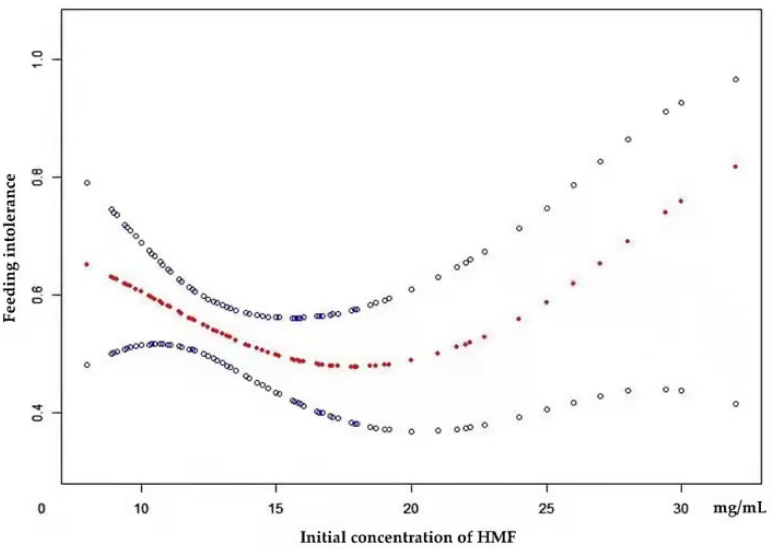
Figure 3. Estimated probability of experiencing feeding intolerance (FI) by initial concentration of human milk fortifier (HMF), based on a generalized additive model controlling for birth weight (BW), rate of milk supplementation, and HM volume when HMF supplement. The red curve in the middle is the spline smoothing, and the blue curve on both sides represents the 95% confidence interval. Table 7. Threshold effect analysis of the relationship between initial concentration of HMF and the risk of FI. Dates, 2015–2018.